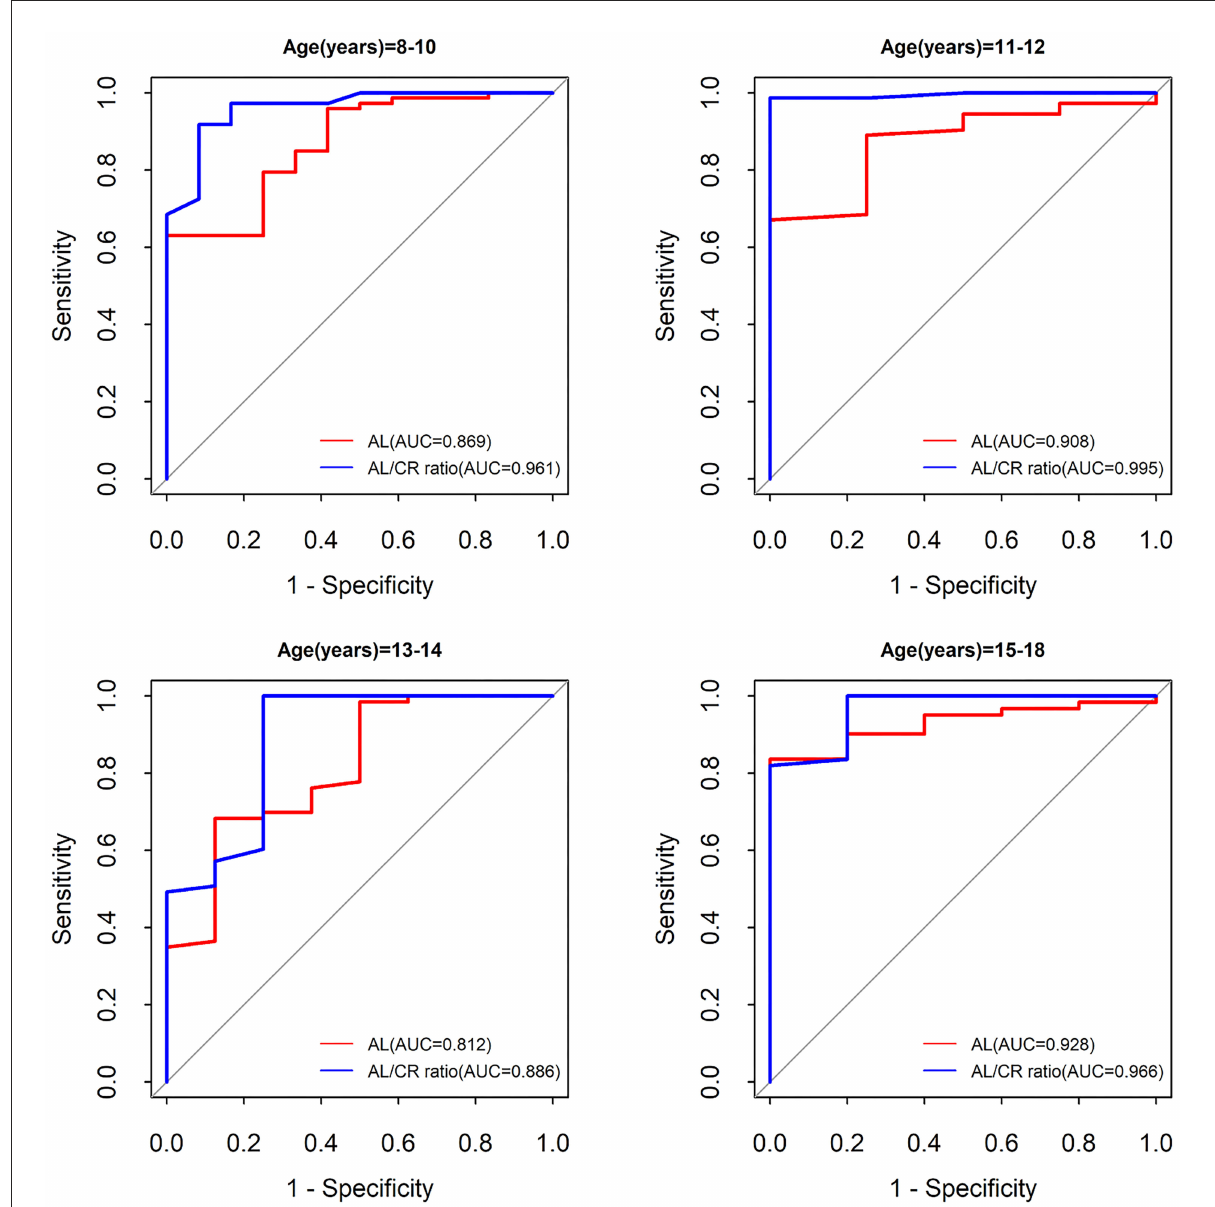
FIGURE5 The comparison of the accuracy of AL and AL/CR ratio for myopia assessment according to age. AL, axial length; AL/CR ratio, axial length/corneal radius ratio; AUC, area under the